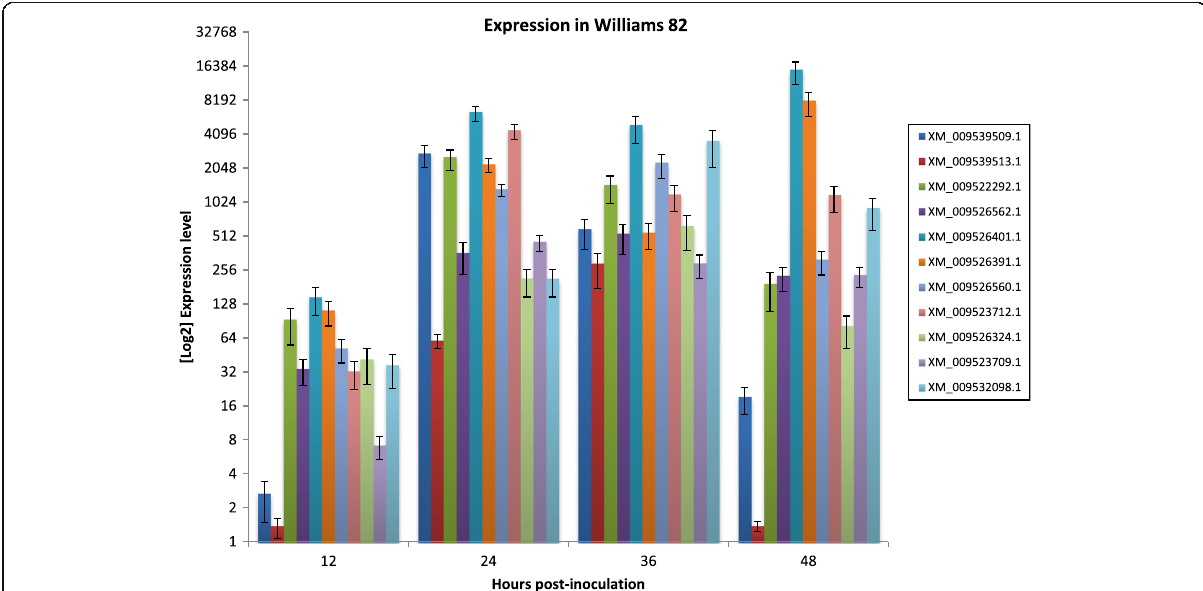
Fig. 6 qRT-PCR analysis of P. sojae PL3-coding genes at several time points after inoculation of soybean plants (cv Williams 82) with P. sojae . Fold expression was calculated by the Livak ( ΔΔ Ct) method using mycelia expression as the calibrating sample and actin as the reference gene. Bars represent standard